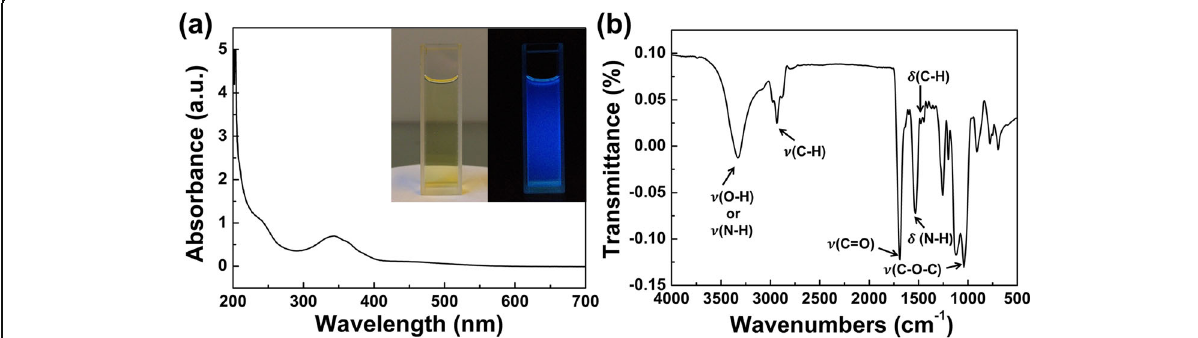
Fig. 2 UV-vis absorption spectrum and FTIR spectrum of as-prepared CDs. a The UV-vis absorption spectrum of CDs. The inset photographs show the as-prepared CDs under natural light ( left ) and under 365 nm irradiation ( right ). b The FTIR spectrum of the